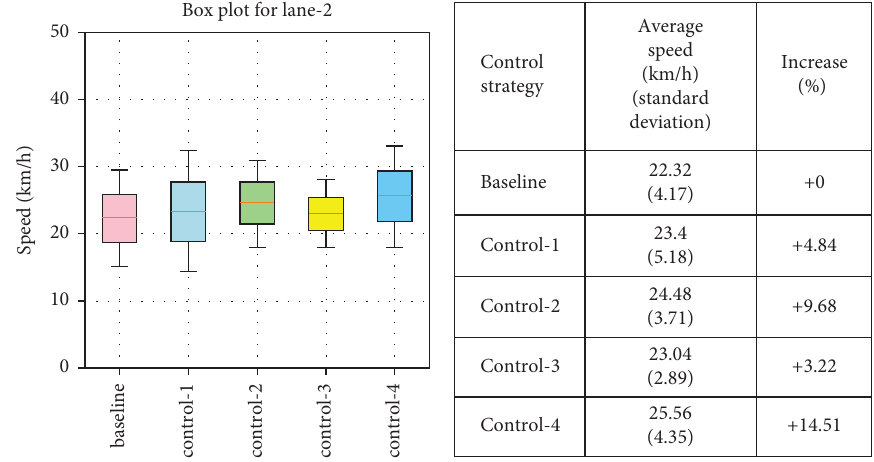
Figure 9: Vehicle speed distribution for diferent control strategies in lane-2.